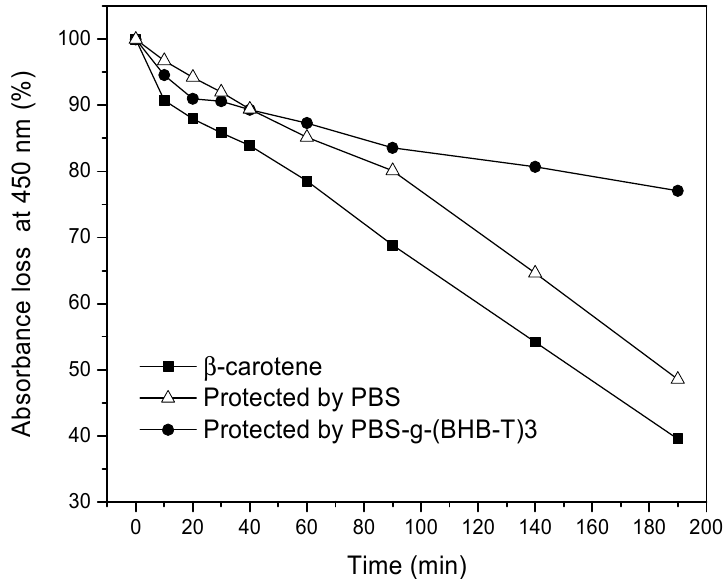
Figure 5. Absorbance loss at 450 nm of β -carotene hexane solution (10 − 5 M) alone or under the protection of PBS and PBS-g-(BHB-T)3 films as a function of irradiation time.